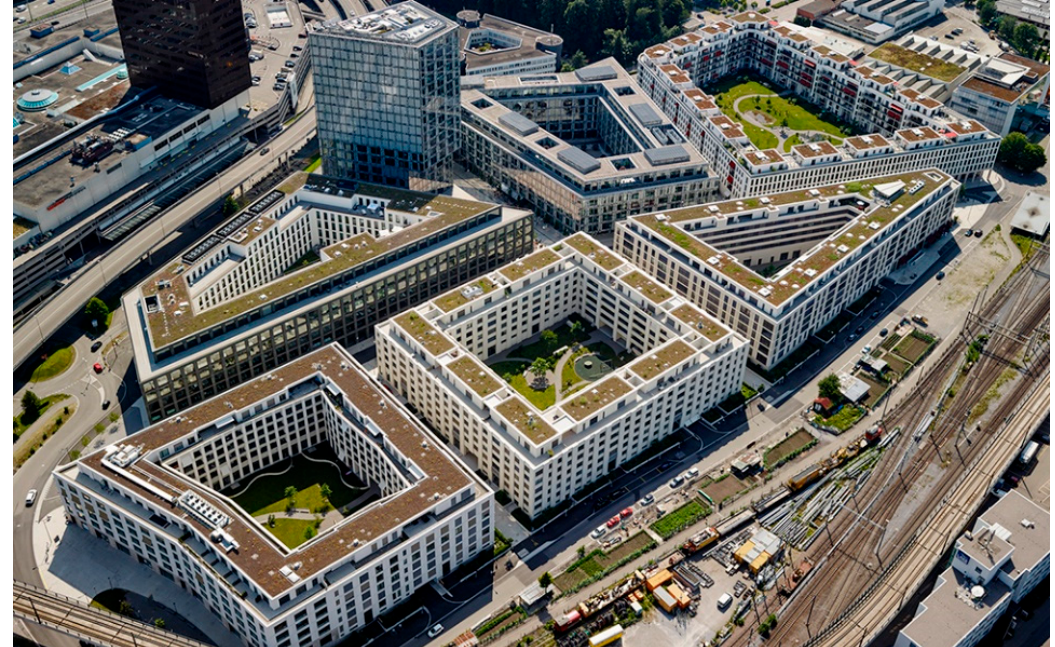
Figure 21. Large-scale urban development in Richti-Areal, Wallisellen near Zurich. Details: 72,000 m 2 construction size, 1200 inhabitants, 2500 jobs, 35% habitation, 55% services, 10% business. ≈ 50 km BHEs (250 BHEs, 200 m deep) . Costs: 500 Mio CHF. For details, see https://de.wikipedia.org/wiki/Richti-Areal (accessed on 13 May 2015).